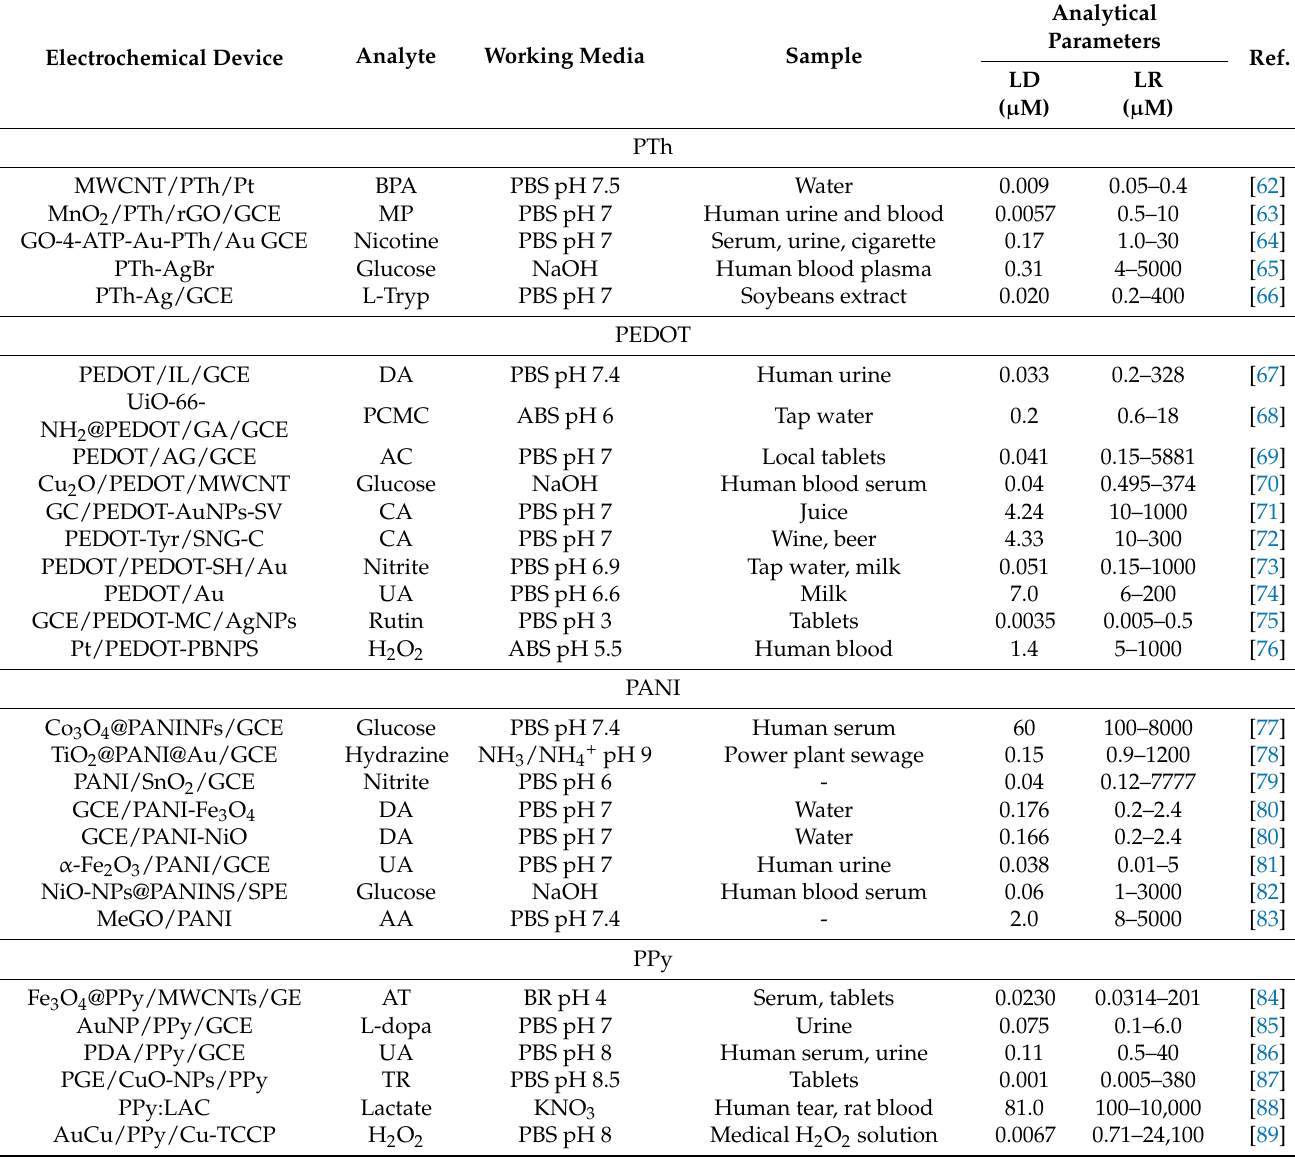
Table 1. Electrochemical sensors based on polythiophene (PTh), poly-(3,4-ethylenedioxythiophene) (PEDOT), polyaniline (PANI), and polypyrrole (PPy) currently reported in